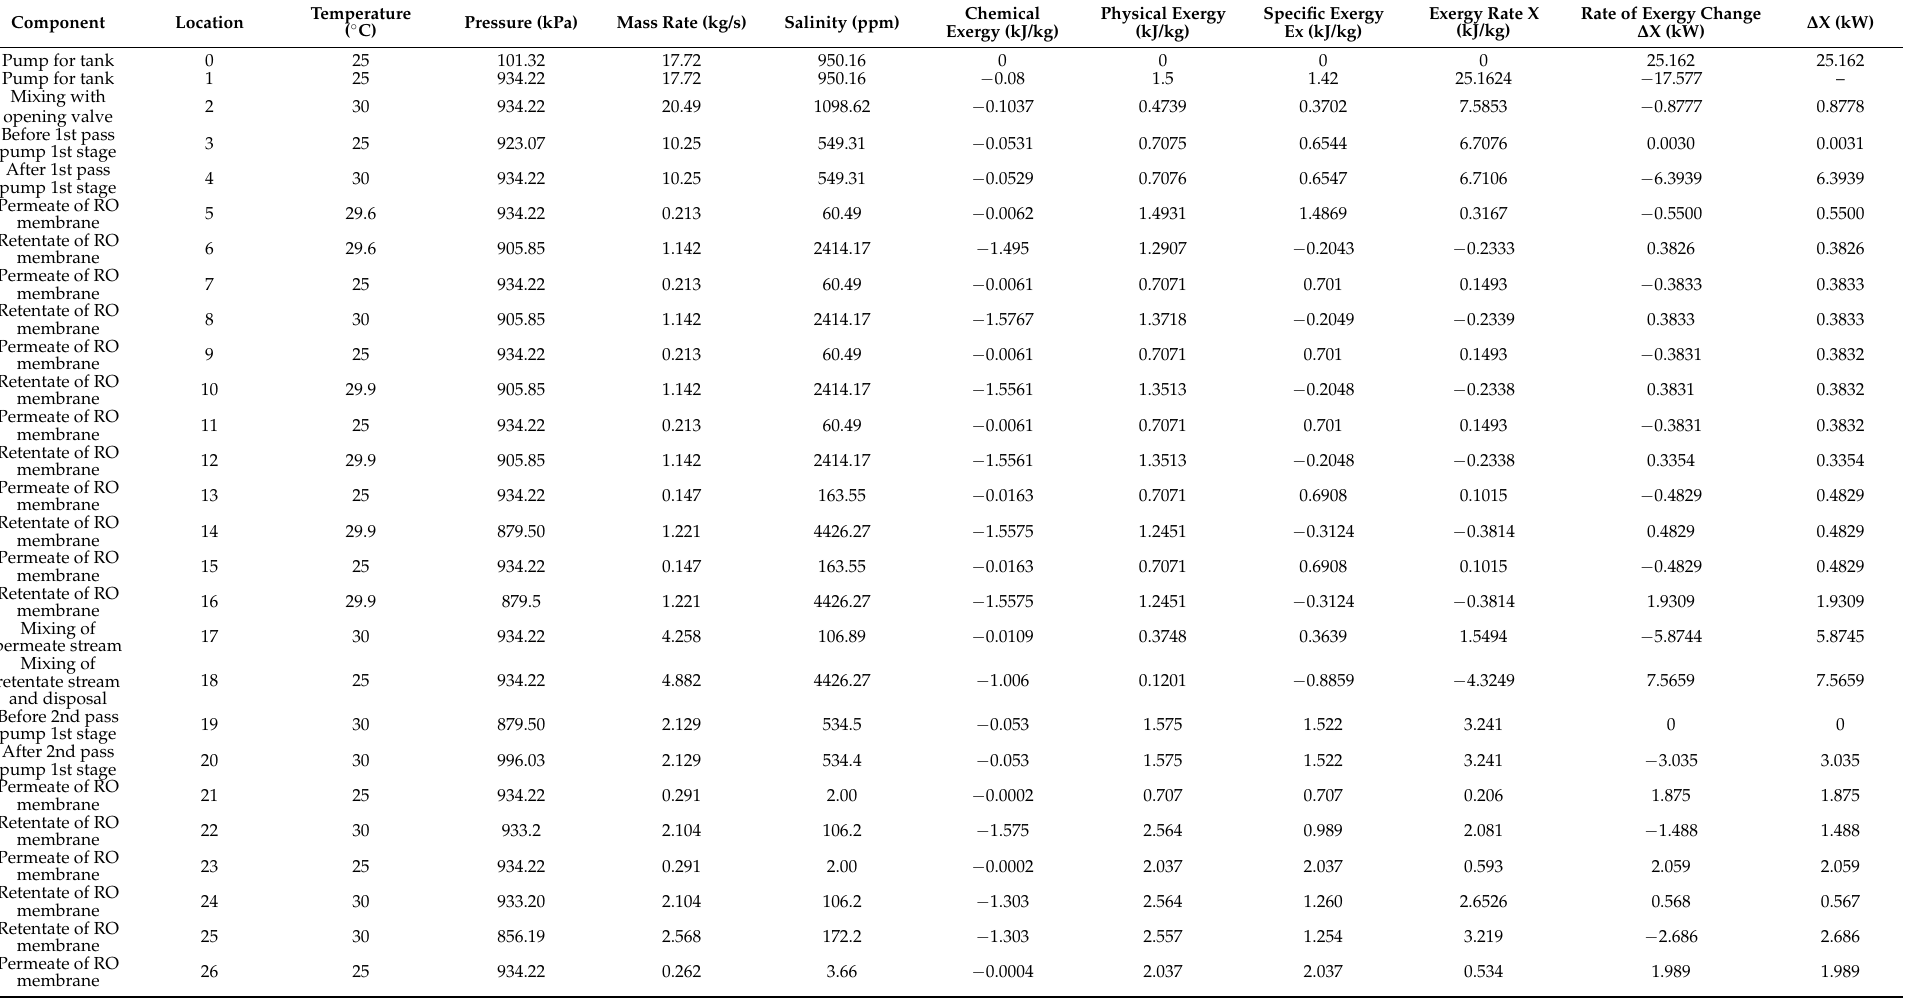
Table 3. Rate of exergy change of major components of the RO system of the APC desalination